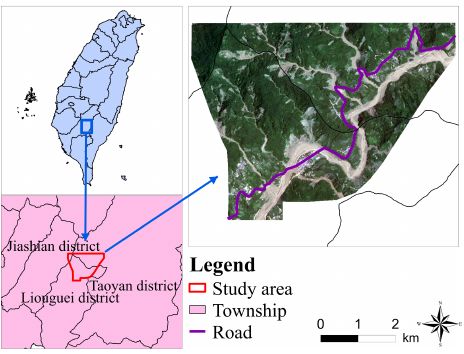
Figure 2. Study area in the south of Taiwan. Purple line depicts the mountain